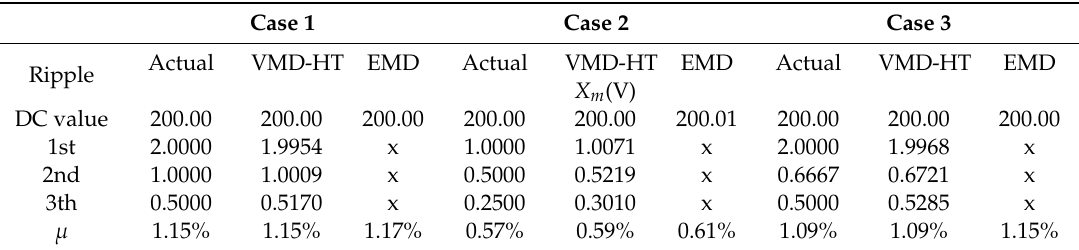
Table 4. Ripple components of DC signals with noise. Figure 14. The decomposed modes of EMD algorithm.